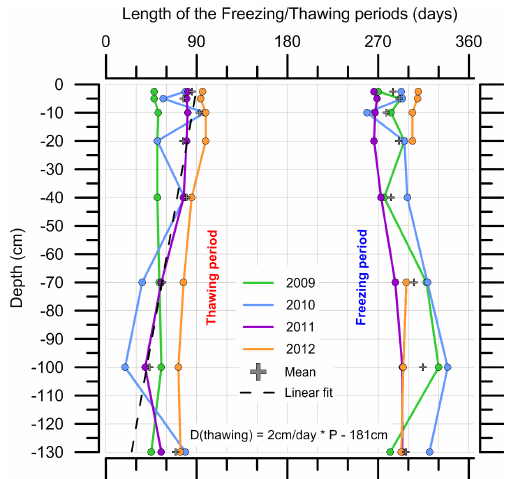
Figure 6. Freezing and thawing period lengths (in days) for each year of the study period, and linear fitting used to derive the depth at which the ground does not have thaw processes, i.e., the depth of the top of the permafrost.